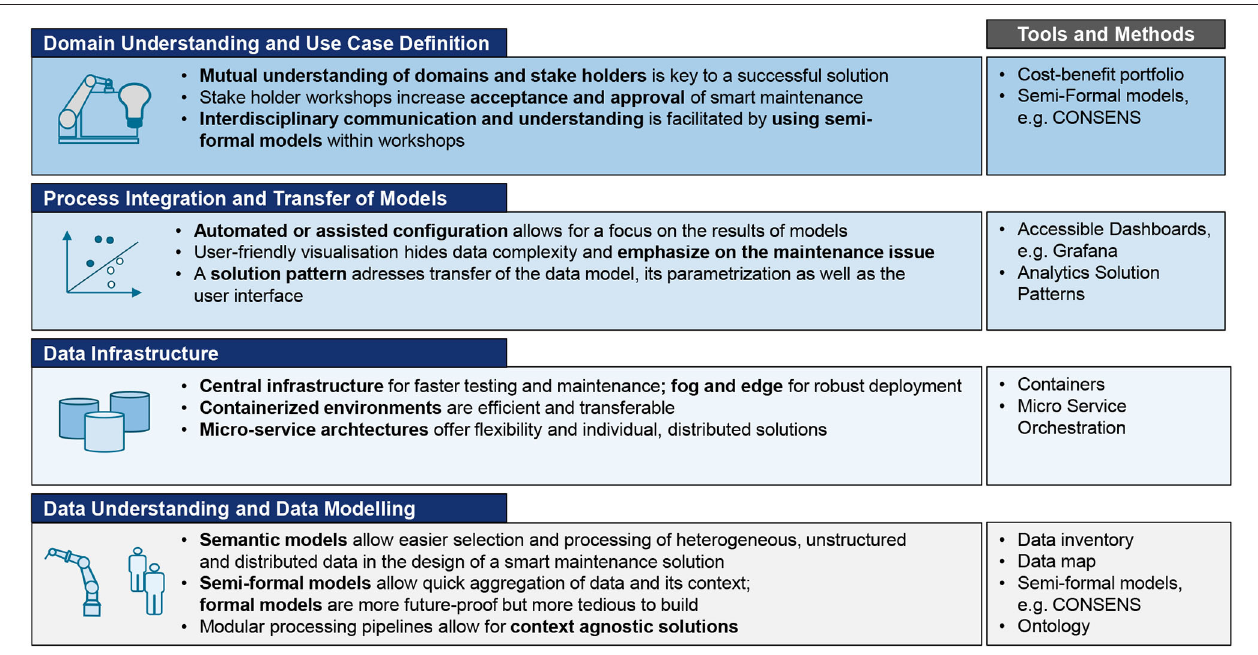
FIGURE 11 | Summary of best practices for successful implementation and deployment of a smart maintenance solution in industrial